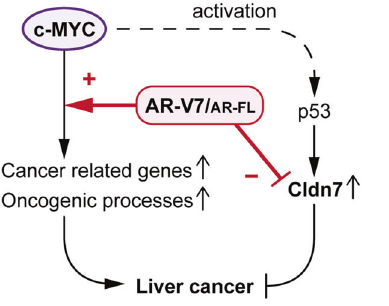
Fig. 5 A schematic diagram illustrating the likely mechanisms of AR-V7 and to a lesser extent AR-FL exacerbate the c-MYC-driven HCC. AR-V7 potentiates the cancer-related genes and oncogenic processes regulated by c-MYC, while it represses a tumor suppressor Cldn7 that is upregulated by c-MYC-overexpression via its activation of the p53 signaling pathway. AR-FL partly exerts similar functions to those of AR-V7 in the presence of androgen in